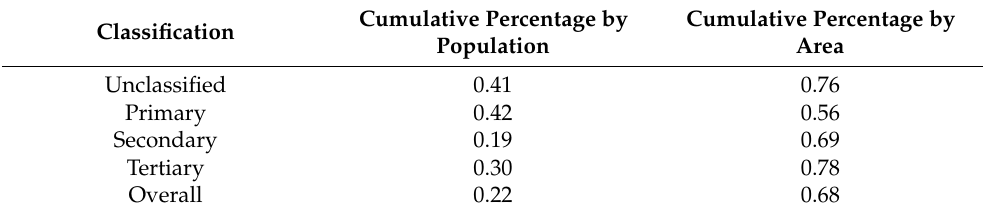
Table 2. Gini coefficient of medical institutions in Guangzhou.